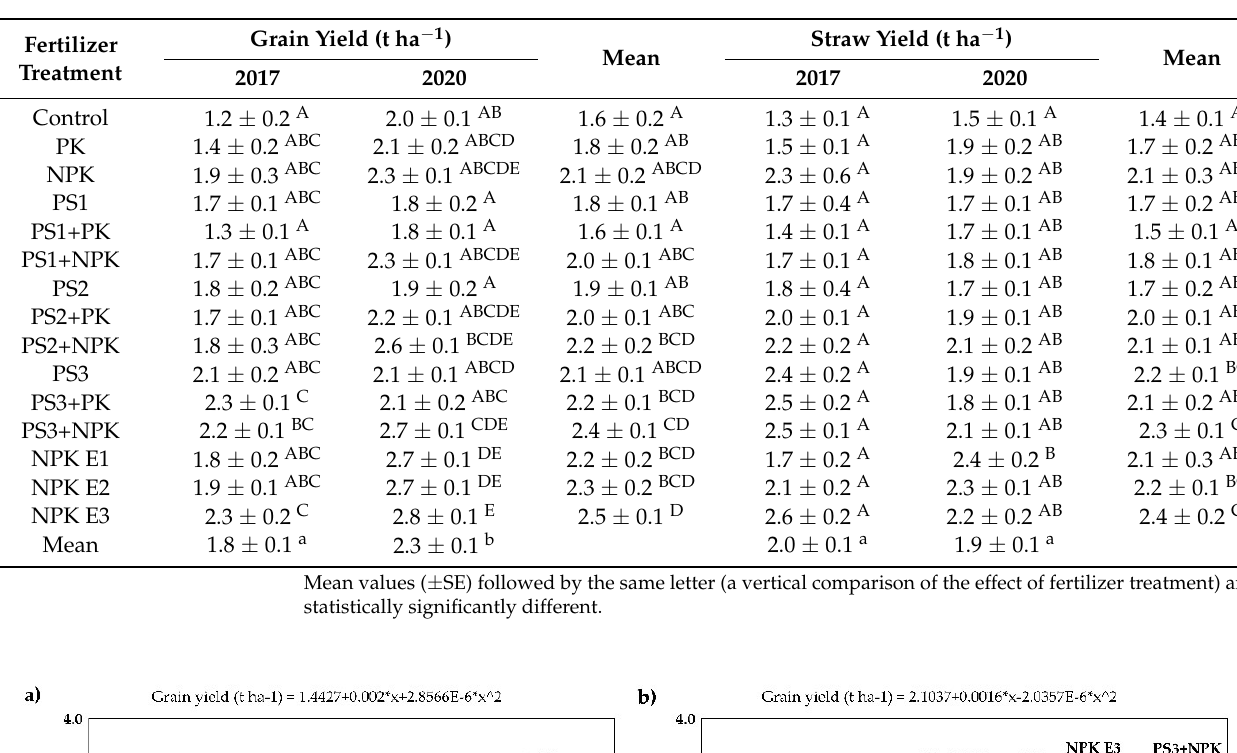
Figure 7. The response of FP yields to different doses of mineral N fertilizers (NPK, NPK E1, NPK E2, NPK E3 treatments) in 2017 ( left ) and 2020 ( right ). Yields (black dots) are interleaved with the linear-plateau model (blue line). The equation of the model is given above the figure.